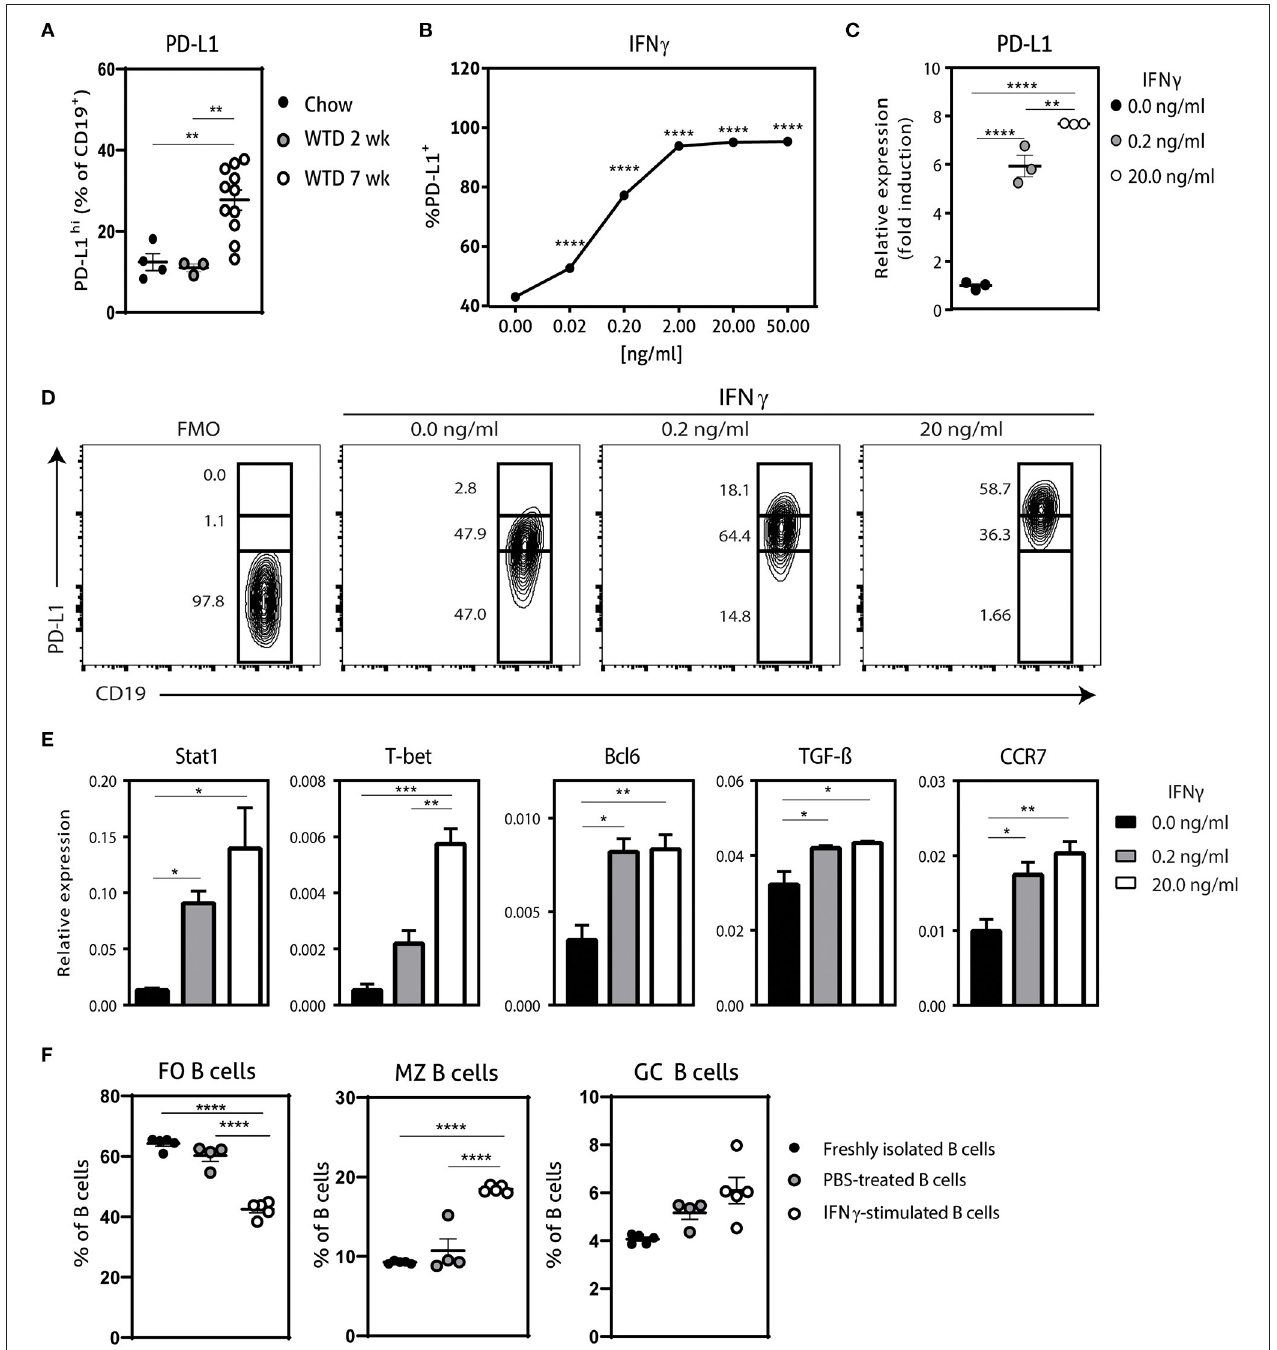
FIGURE 1 | Characterization of IFN γ -stimulated B cells. (A) PD-L1 hi expressing CD19 + B cells were determined in spleens of apoE − / − mice fed a regular Chow diet or Western type diet for 2 or 7 weeks using flow cytometry. (B) CD19 + B cells were isolated from C57BL/6 mice and stimulated for 24h with different doses interferon-gamma (IFN γ ) after which PD-L1 protein expression was measured with flow cytometry. (C) CD19 + B cells were unstimulated or stimulated with 0.2ng/ml or 20.0ng/ml IFN γ for 24h, after which mRNA expression of PD-L1 was assessed using qPCR. (D) B cells as stimulated in (C) were analyzed for PD-L1 lo , PD-L1 int and PD-L1 hi expression with flow cytometry. (E) mRNA expression was analyzed for depicted genes in B cells as stimulated in (C) . (F) FO B cells (CD23 + ) MZ B cells (CD23 − CD21 + ) and GC B cells (GL-7 + CD95 + ) were determined in CD19 + B cells stimulated with 20.0ng/ml IFN γ for 24h. Data are analyzed with a One-Way ANOVA and shown as mean ± SEM ( * p < 0.05, ** p < 0.01, *** p < 0.001, **** p < 0.00001). n = 3–11/group.